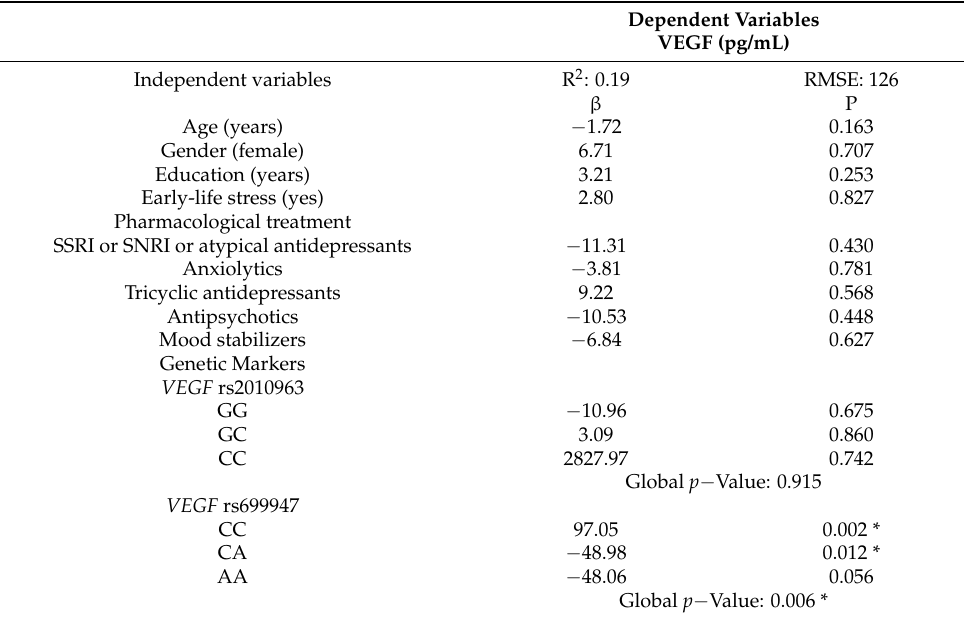
Table 3. Multivariate linear regression analysis showing the influence of genotypes on VEGF plasma concentrations and additive model in the depressive